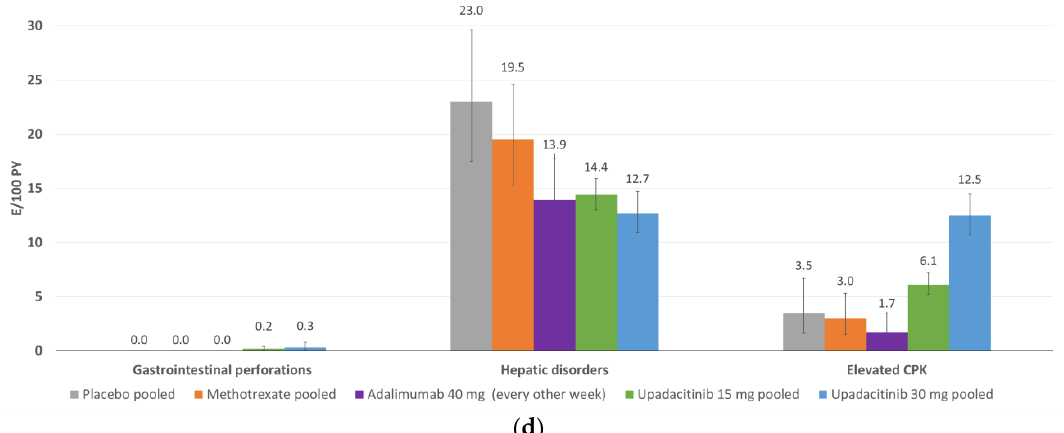
Figure 4. ( a ). Event rates for infections. ( b ). Event rates for malignancies. ( c ). Event rates for major adverse cardiovascular events and venous thromboembolism. ( d ). Event rates for other events of special interest: gastrointestinal perforation, hepatic disorders and CPK elevations. E/100 PY — events per 100 patient-years. NMSC — non-melanoma skin cancer. MACE — major adverse cardiovascular event; VTE — venous thromboembolic event. CPK — creatin phosphokinase.